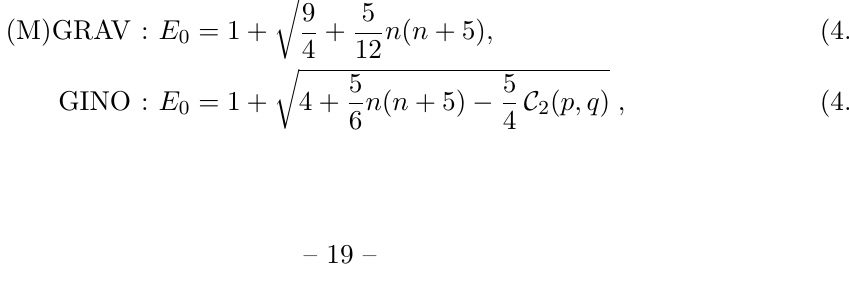
N = 1 solution [29, 52, 54] of 2